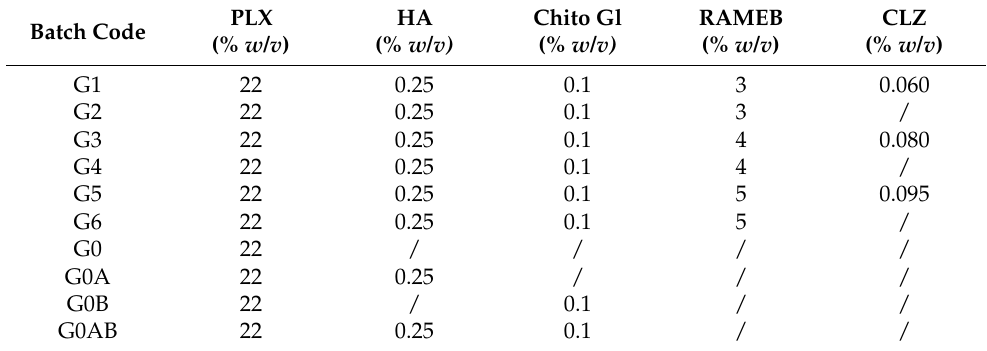
Table 2. Composition of the gel